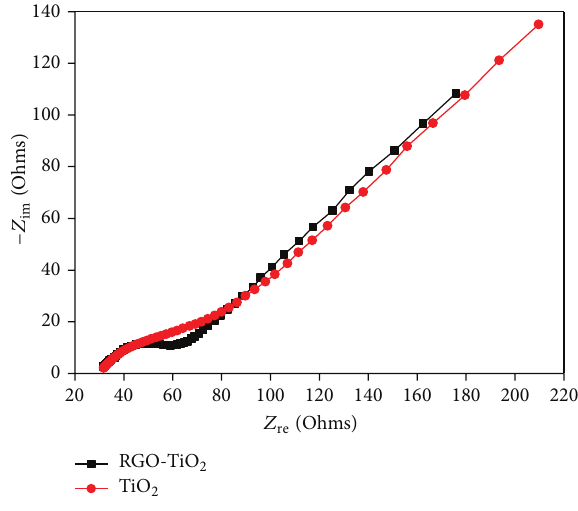
Figure 8: EIS measurement of TiO 2 and RGO-TiO 2 composite elec- trodes in the presence of 0.1M KCl containing 1mM K 4 [Fe(CN) 6 ].